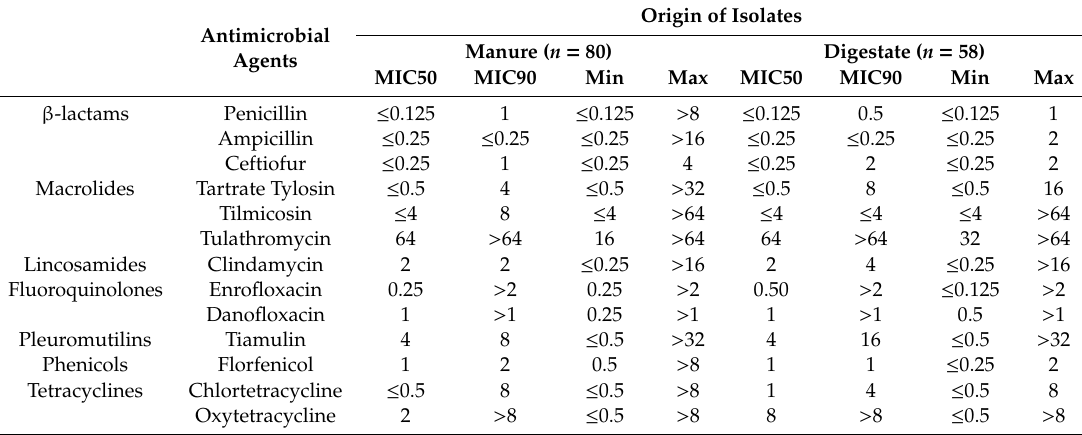
Table 5. Minimum inhibitory concentration (MIC) distribution (µg/mL) of 13 antimicrobials tested against 138 isolates of C. perfringens originating from three BPGs.